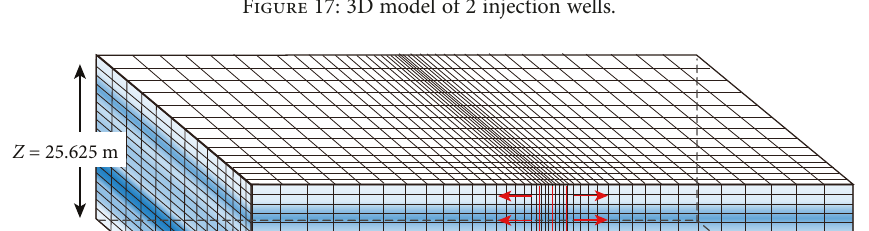
Figure 17: 3D model of 2 injection wells.